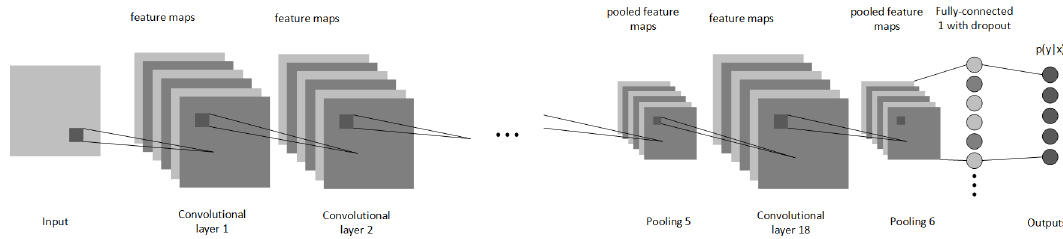
Figure 2. A single branch of ANN used for reconstruction of voxel